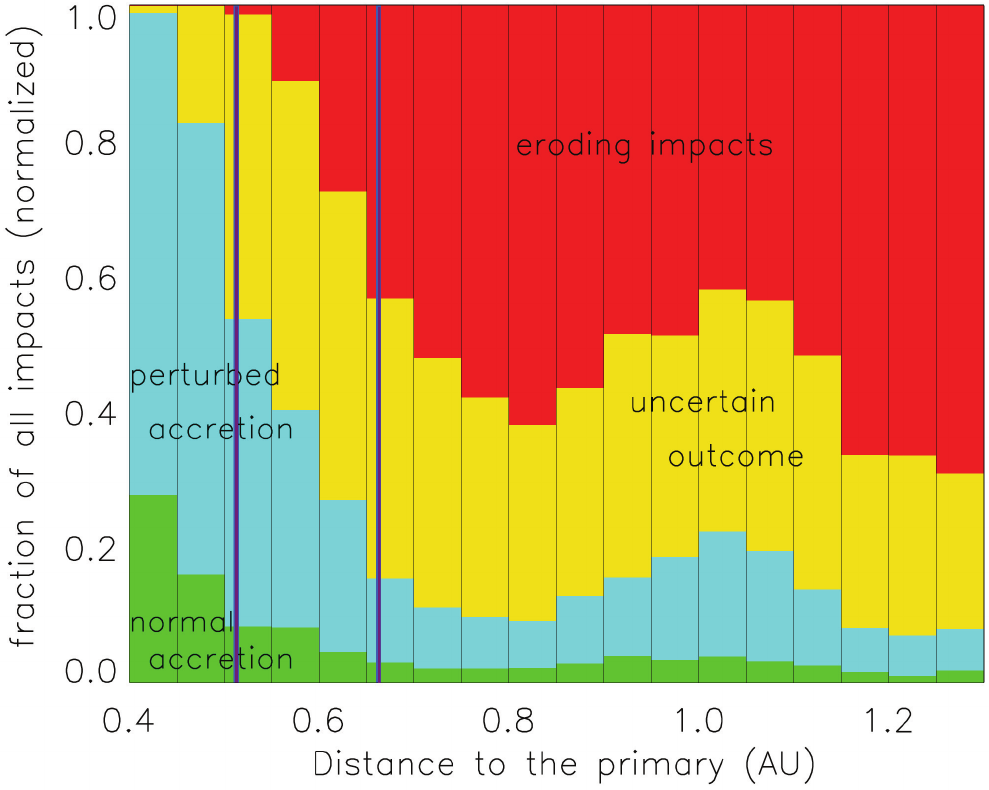
Figure 5. The accretion behavior in a planetesimal disk around α Cen B, estimated with numerical simulations taking into account gas drag. The relative importance of different types of collisional outcomes is displayed as a function of radial distance. Red : impacts for which the impact velocity ∆ v s 1 , s 2 ≥ v ero − M , where v ero − M is the threshold velocity beyond which an impact between two objects of sizes s 1 and s 2 always results in net mass loss. Yellow : Uncertain outcome. The erosion vs. accretion ≤ v esc , where v esc net balance depends on the physical composition of the planetesimals. Green : ∆ v s 1 , s 2 is the escape velocity of the ( s 1 , s 2 ) pair. Accretion can here proceed unimpeded, in a “runaway growth” ≤ v ero − m . Collisions result in net accretion, way, as around a single star. Light blue : v esc ≤ ∆ v s 1 , s 2 but ∆ v are high enough to switch off the fast-runaway growth mode. The two thick blue lines denote the location of the inner limit of the “optimistic” and “conservative” habitable zone around the star. The planetesimal size distribution is assumed to be a Maxwellian centered on 5km (modified from